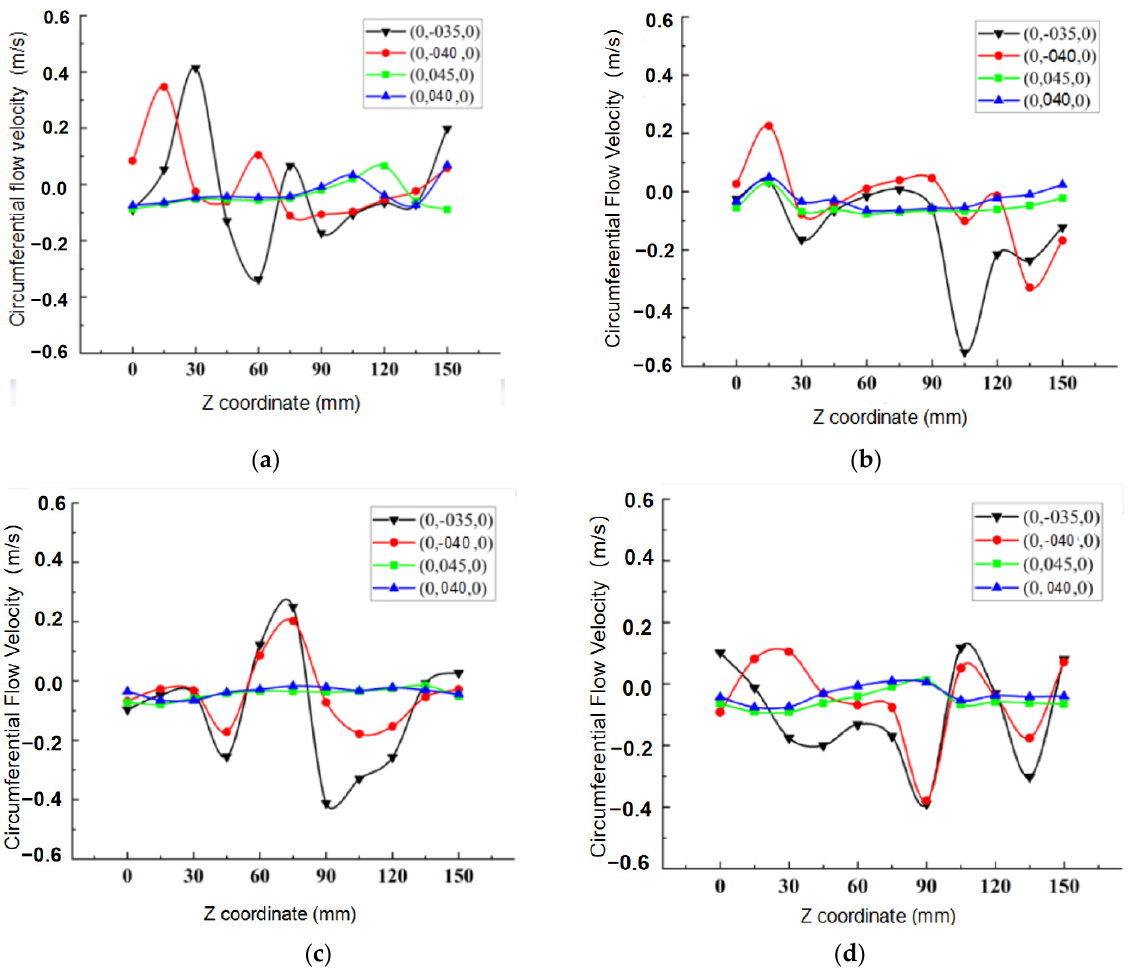
Figure 7. Variation curve of circumferential flow velocity at horizontal measuring points of annular slit flow. ( a ) Position 1; ( b ) position 2; ( c ) position 3; ( d ) position 4.